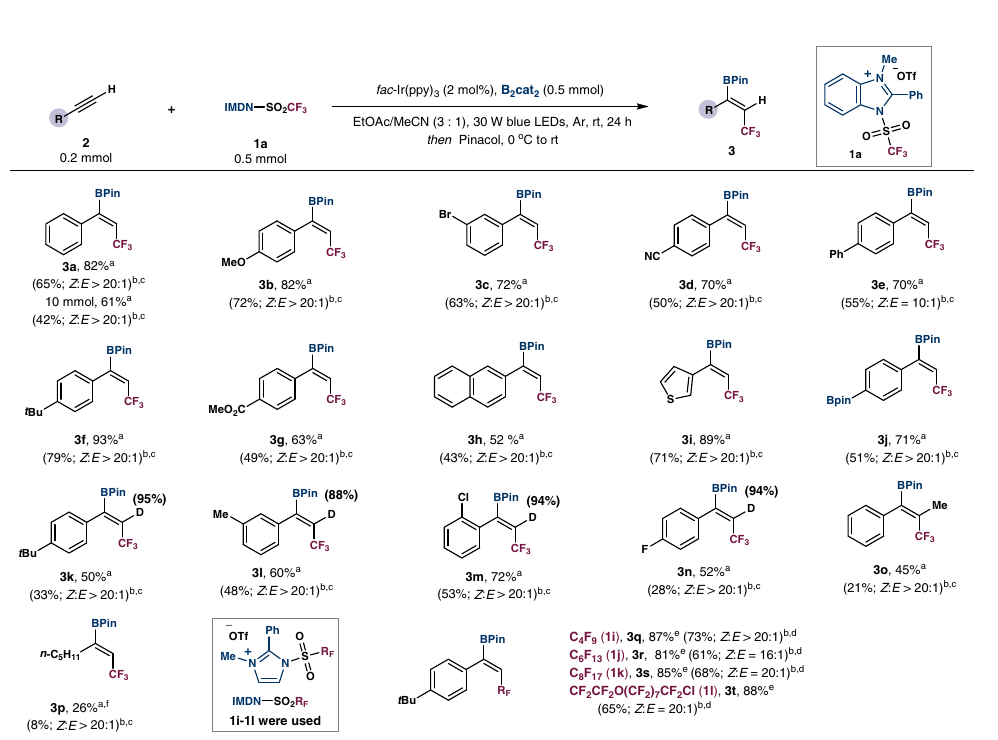
Fig. 2 Substrate scope of the alkynes. a Crude yields determined by 19 F NMR spectroscopy using benzotri fl uoride or tri fl uoromethoxybenzene as an internal standard. b Values in parentheses are of isolated yields. c The E / Z ratio was determined by 19 F NMR. d The E / Z ratio was determined by 1 H NMR. e Crude yields determined by 1 H NMR spectroscopy using dibromomethane as an internal standard. f 2.0 mmol of 2p was